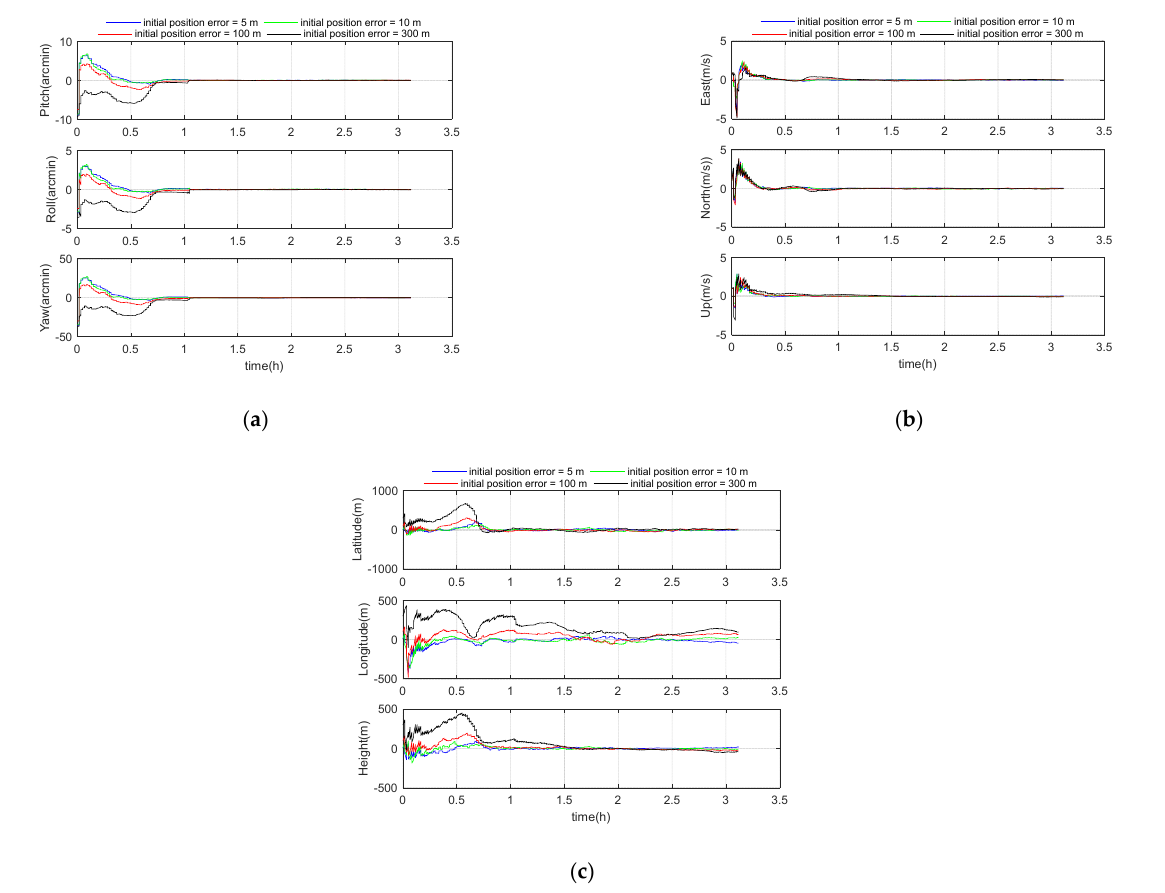
Figure 9. ( a ) Attitude error curve; ( b ) velocity error curve; ( c ) position error curve. Table 8. Simulation results under different initial position errors.